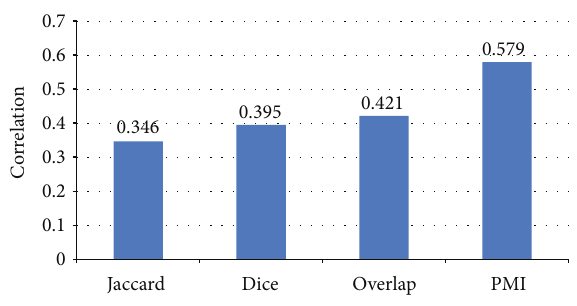
Figure 5: The correlation of four selected functions.